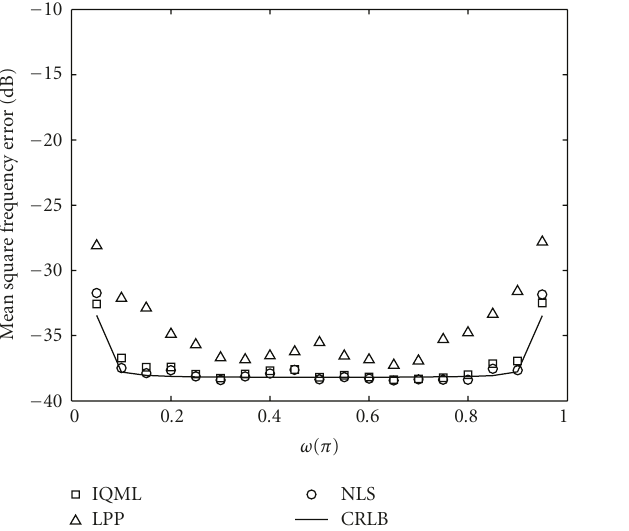
Figure 14: MSE for ω of single real sinusoid at SNR = 20 dB.